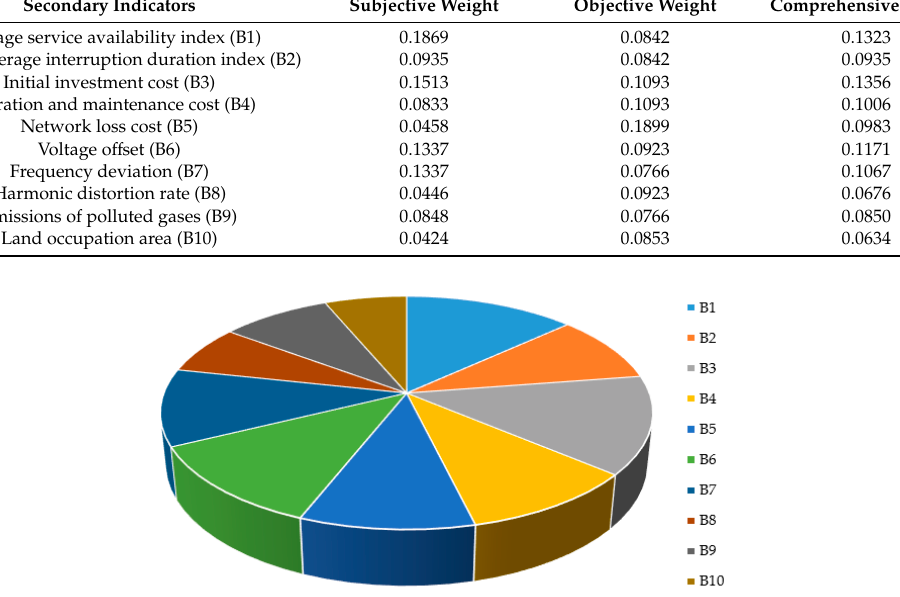
Appl. Sci. 2019 , 9 , 3843 Figure 6. The objective weights of each evaluation indicator. Figure 6. The objective weights of each evaluation indicator.